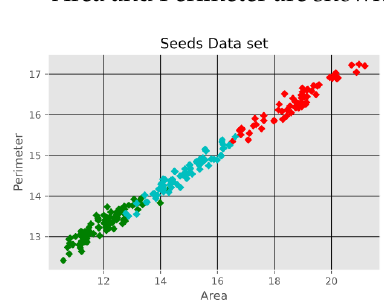
and Perimeter are shown in Figure 5.